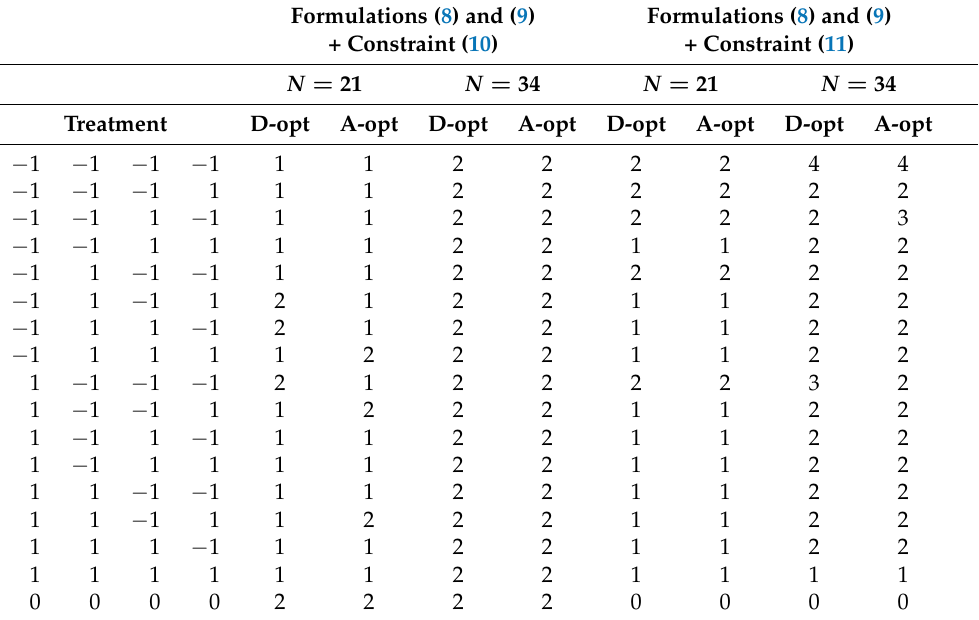
Table 7. Constrained D- and A-exact optimal designs for Model 3, where k = 17, N = { 21,34 } and constraints (10) and